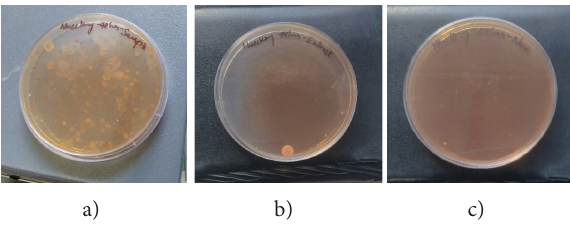
a) b) c) Plate 3. Sample treated with AgNP and AEIC of Imperata